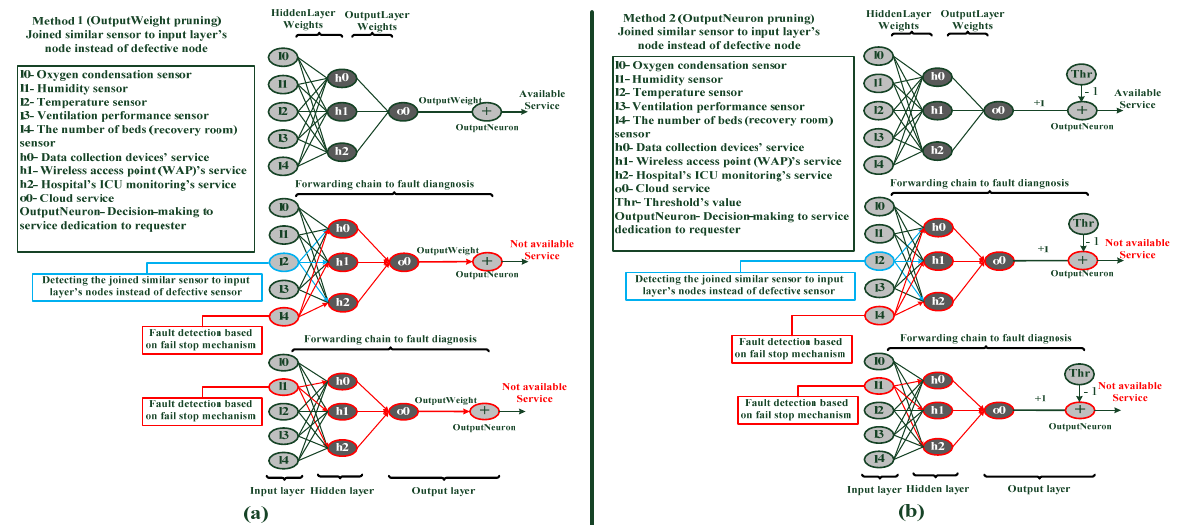
Figure 7. The efficiency of a joined sensor to input layer’s nodes instead of the defective node for different methods to decision-making about dedicating service to a requester with high quality and forwarding chain to fault detection: ( a ) Method 1 based on pruning weak weight (output weight) and output neuron in output layer; ( b ) Method 2 is based on pruning weak output neuron in the output layer.